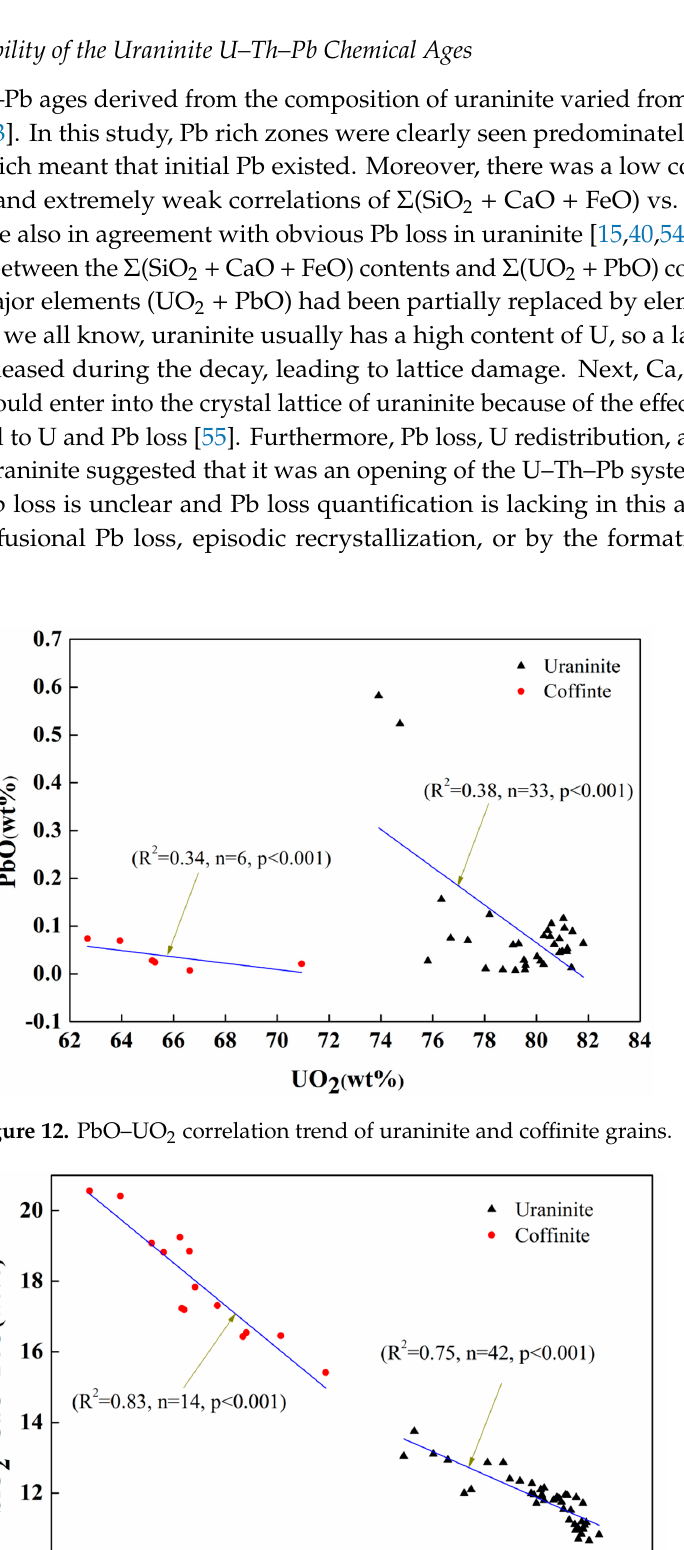
+ PbO vs. SiO + CaO + 2 2